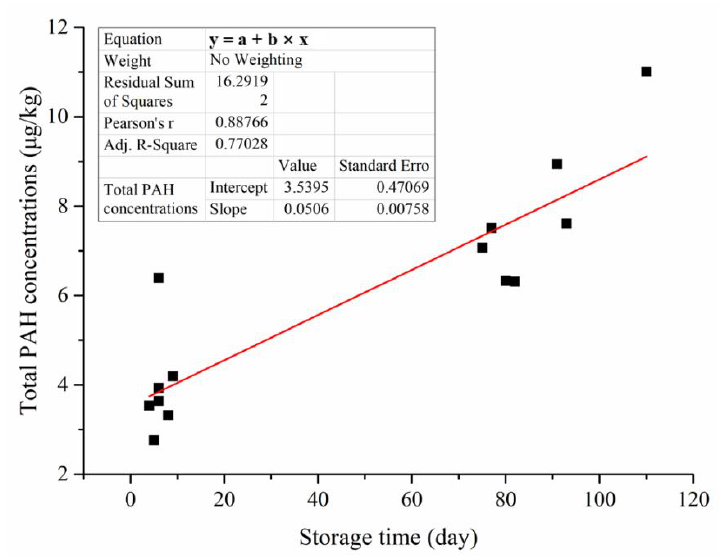
Figure 4. Correlation analysis of storage time and total PAH concentration in milks. Red line: the linear regression model.